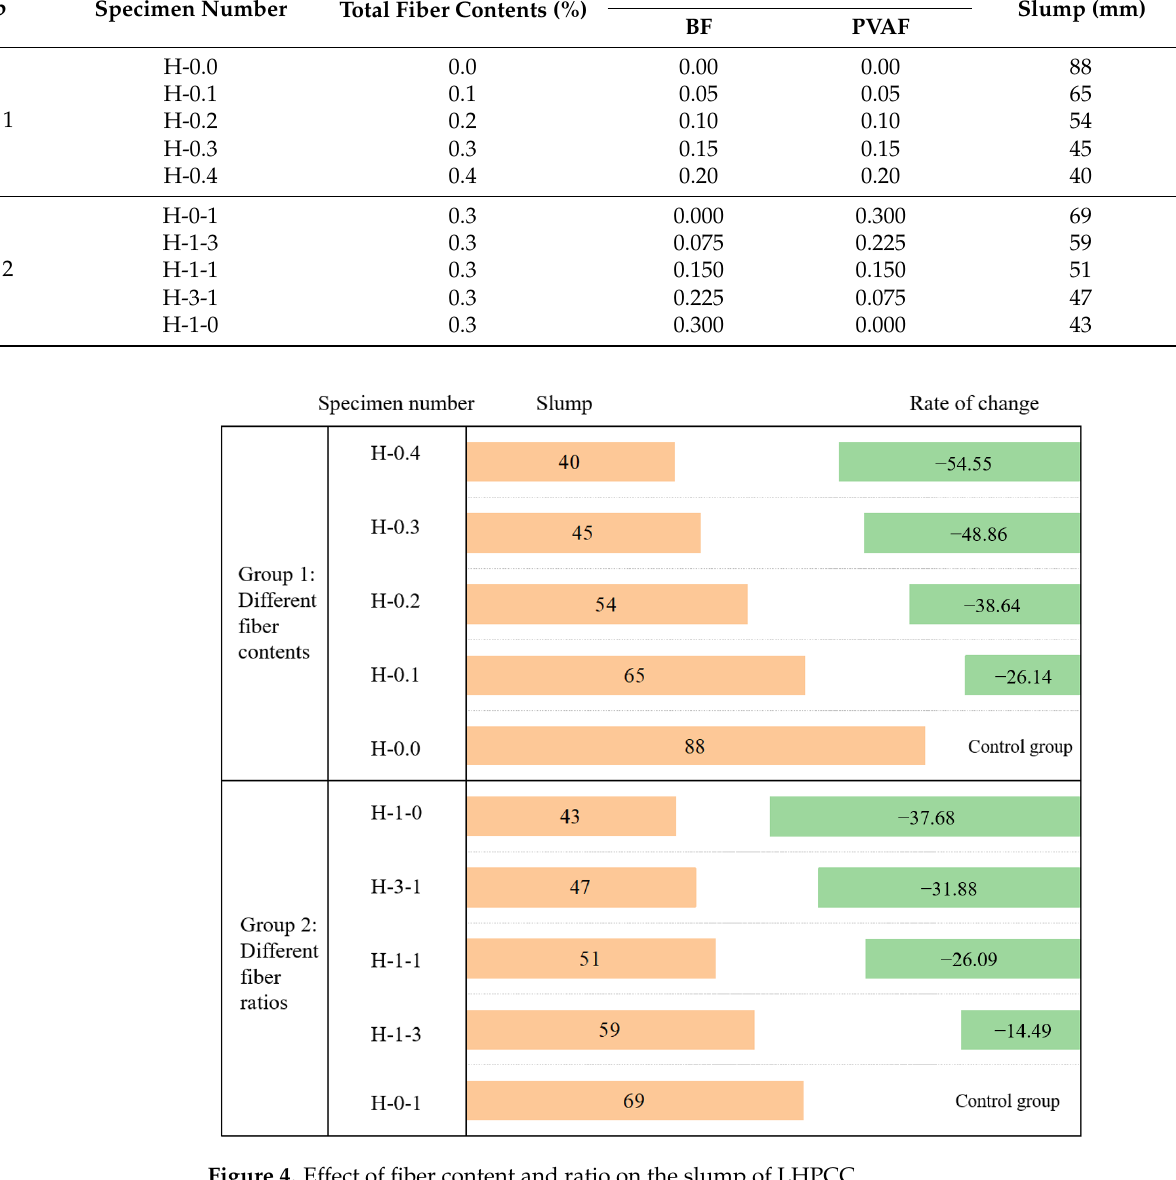
Figure 4. Effect of fiber content and ratio on the slump of